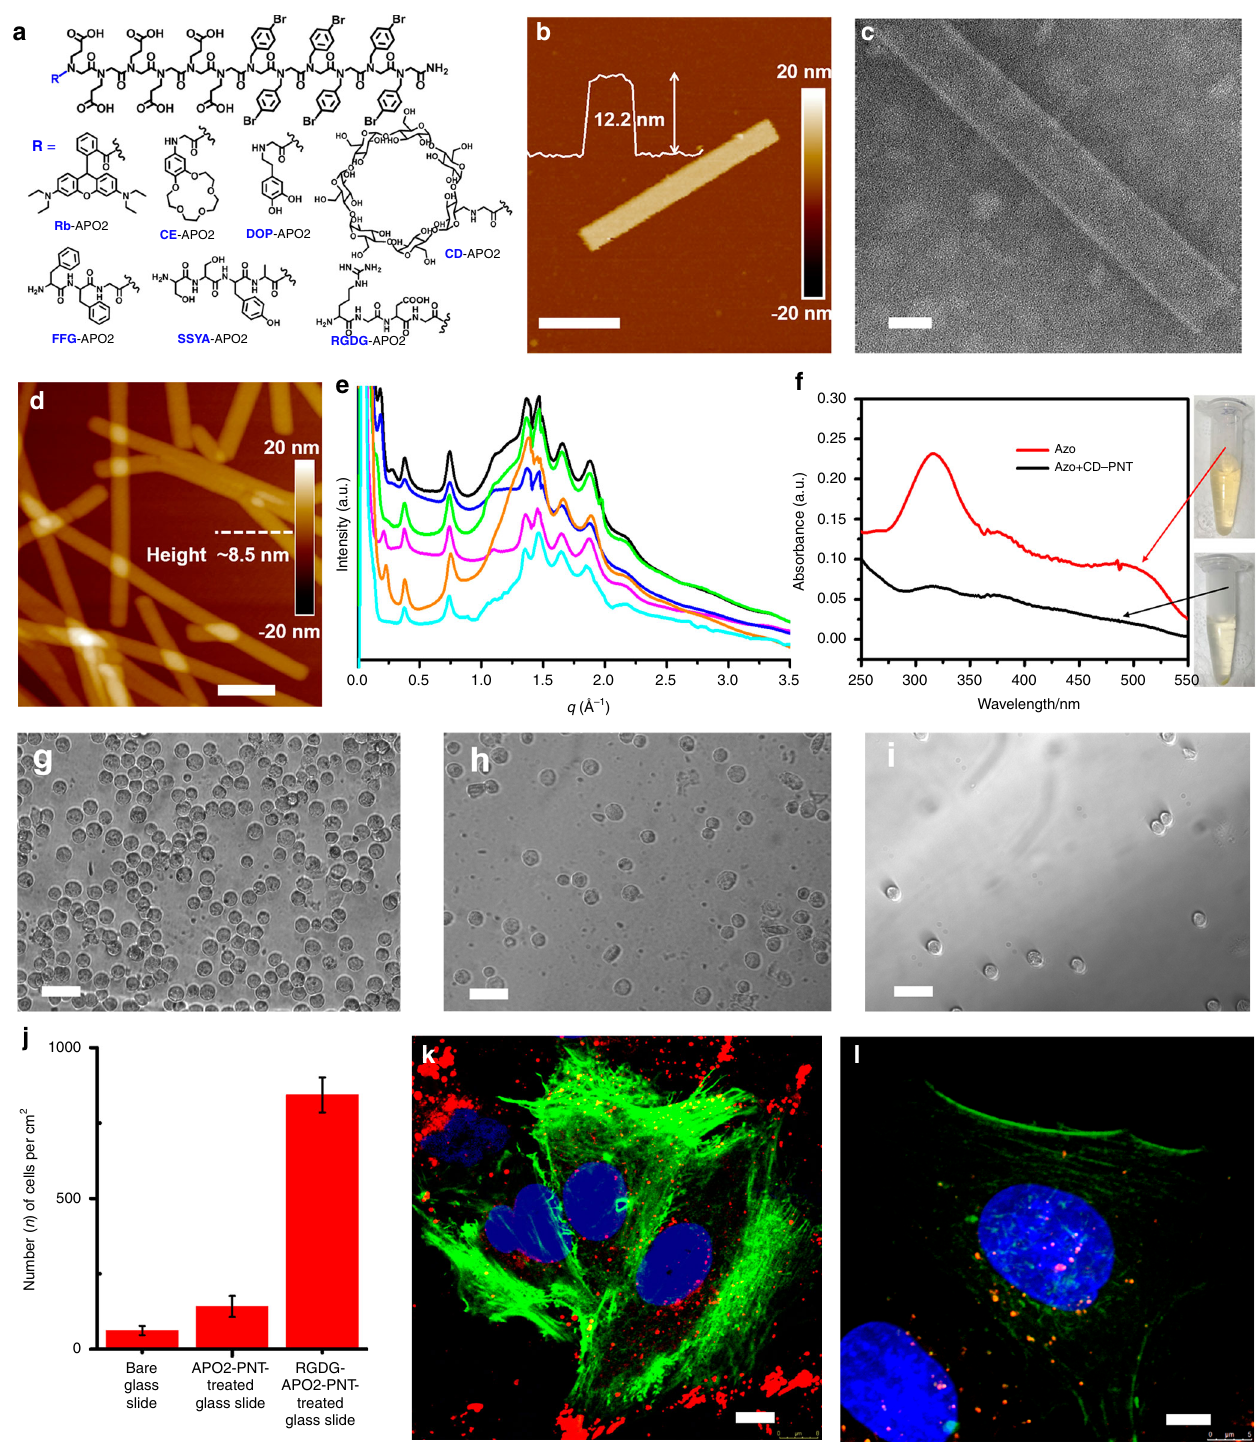
respectively. It is assumed that there is no initial deformation between PNTs and the mica surface. The viscoelastic effect induced by the surrounding fl uid environment was neglected in this model. Figure 5c displayed the raw shape of the model PNT in fi nite element software. A quarter-symmetric model incorpor- ating corresponding symmetric boundary conditions was imple- mented to reduce computation time. Figure 5d depicted that under the high load of the AFM tip, PNTs underwent an intense deformation. The deformation features were completely